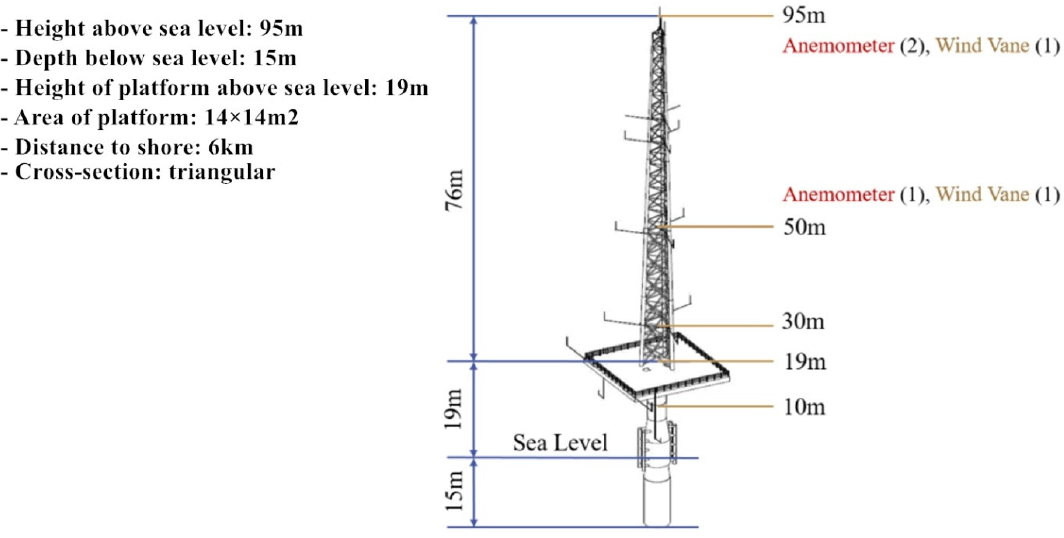
Fig ure 3. Taipower offshore meteorological mast. Figure 3. Taipower offshore meteorological